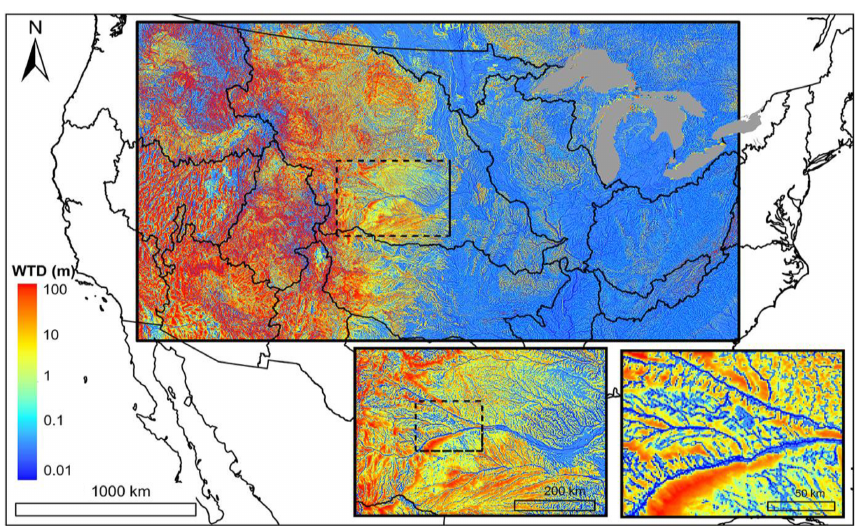
Figure 6. Map of water table depth (m) over the simulation domain with two insets zooming into the North and South Platte River basin, headwaters to the Mississippi River. Colors represent depth in log scale (from 0.01 to 100m) (reproduced from Maxwell et al., 2015). The domain uses 1km 2 grid cells and represents one of the largest and highest-resolution domains simulated by integrated models to date.